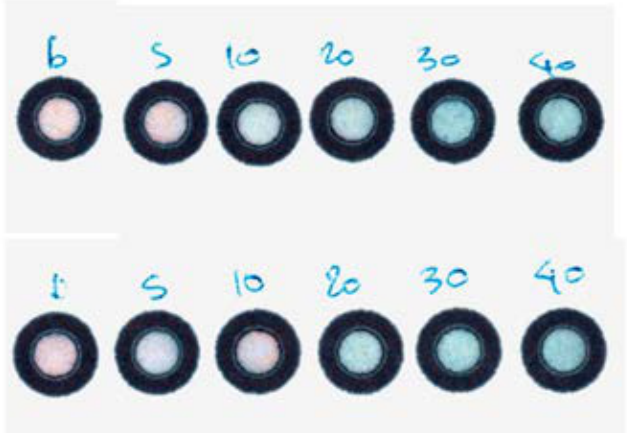
Figure 4. Color alteration for calcium determination according to the method, in the concentration range between 5 and 40 mg L −1 , visible even to the naked eye.